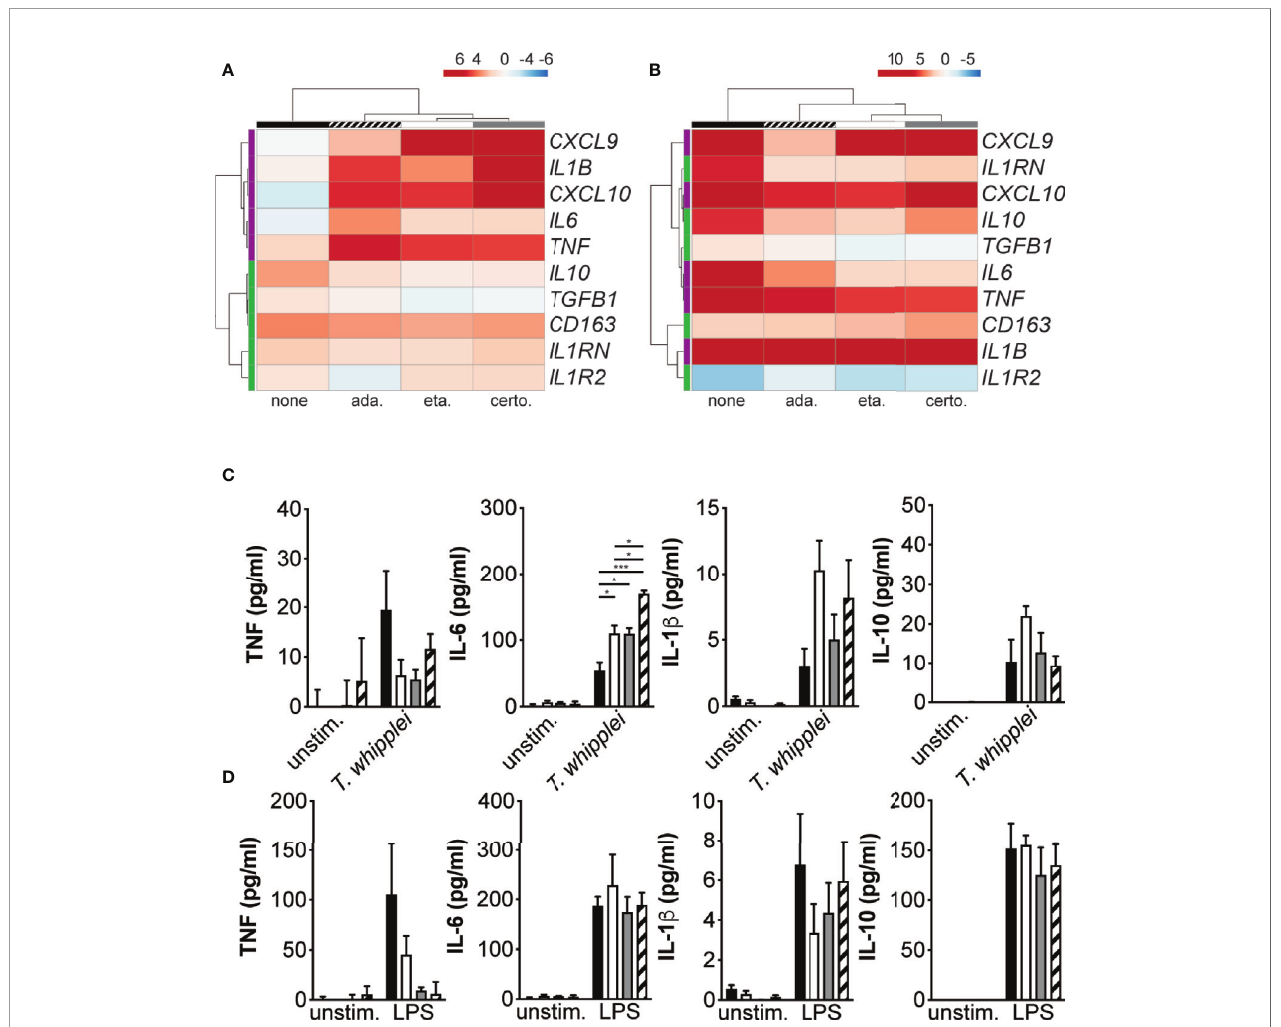
FIGURE 2 | TNFI interfere with macrophage polarization. (A, B) Macrophages were stimulated for 6 h with T. whipplei (A) or LPS (B) in the presence or not of etanercept, certolizumab or adalimumab. The expression of macrophage M1 (purple) and M2 (green) polarization genes was investigated by qRT-PCR after normalization to the actin endogenous control and expressed as log2-transformed-foldchanges relative to the appropriate unstimulated condition. The experiment was performed using three (N = 3) or six different donors (N = 6) for T. whipplei or LPS stimulation, respectively. The mean log2-transformed-foldchange value was used in the ClustVis webtool to generate the heat-maps. (C, D) Macrophages were stimulated for 24 h with T. whipplei (C) or LPS (D) in the presence of etanercept (white bars), certolizumab (grey bars) or adalimumab (hashed bars) or left untreated (black bars) and TNF, IL-6, IL-1 b and IL-10 release in the culture supernatants was assessed by ELISA (N = 3). The experiment was performed using three different donors (N = 3), and the values represent the mean ± standard error of the mean. * and *** P < 0.05 and 0.001, respectively by two-way ANOVA and the Tukey ’ s test for post-hoc